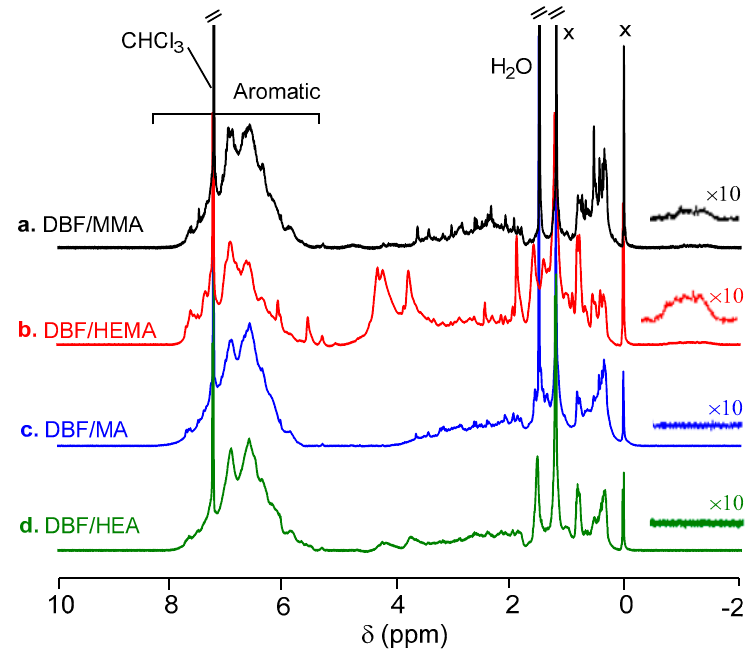
Figure 1. 1 H NMR spectra of poly(DBF- co -MMA) ([DBF]/[MMA] in polymer = 82/18) (a), poly(DBF- co -HEMA) ([DBF]/[HEMA] in polymer = 73/27) (b), poly(DBF- co -MA) ([DBF]/[MA] in polymer = 87/13) (c), and poly(DBF- co -HEA) ([DBF]/[HEA] in polymer = 89/11) (d) (400 MHz, CDCl 3 , room temperature). X denotes